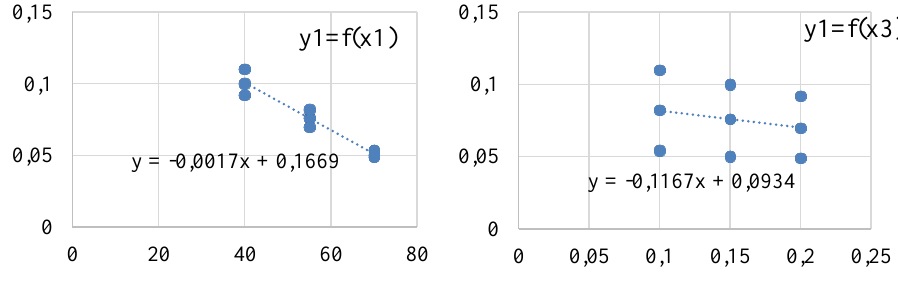
Fig. 6. One-factor graphic